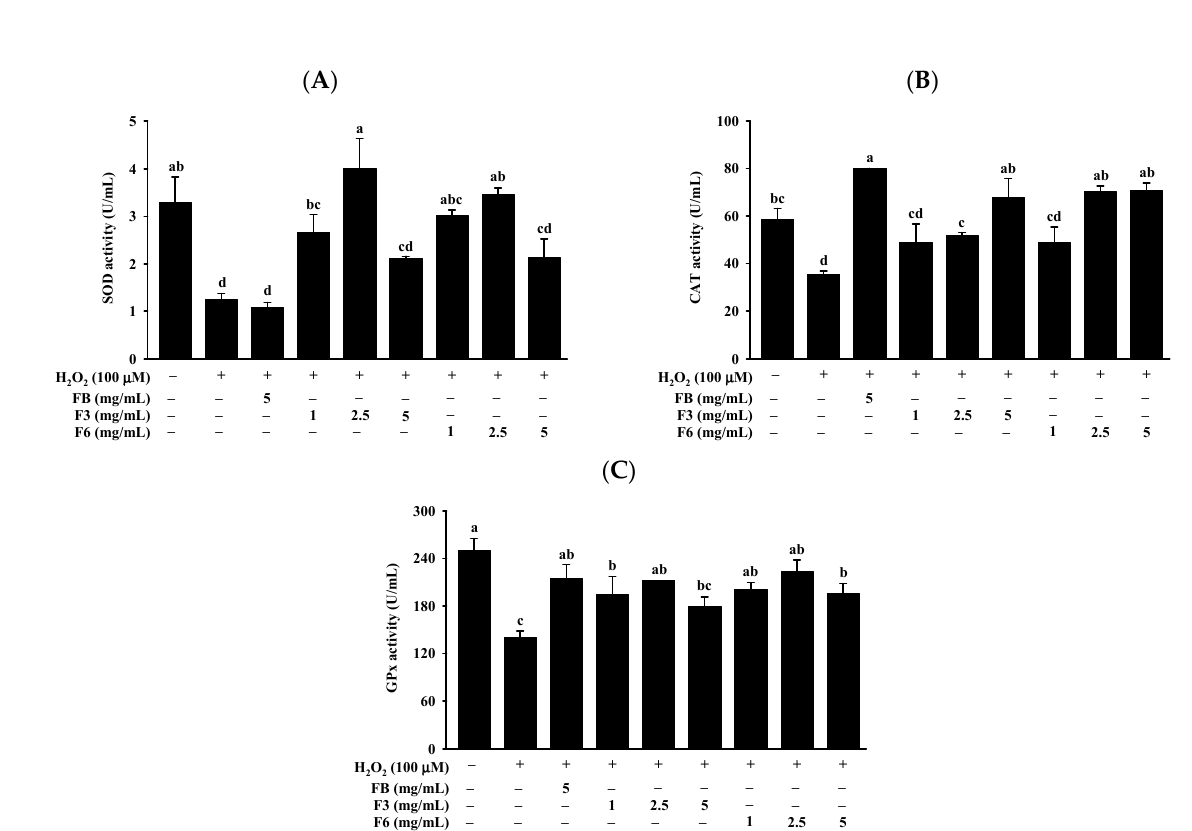
Figure 4. Effect of FB, F3, and F6 on activity of ( A ) SOD, ( B ) CAT, and ( C ) GPx in H 2 O 2 -induced Clone-9 cells. Data are expressed as mean ± SD ( n = 3). Tukey’s tests were performed, with similar superscripts (a–d) among each group indicating non-significant difference ( p < 0.05). FB: fish bone; F3: fish bone fermented with Monascus purpureus for 3 days; F6: fish bone fermented with Monascus purpureus for 6 days.